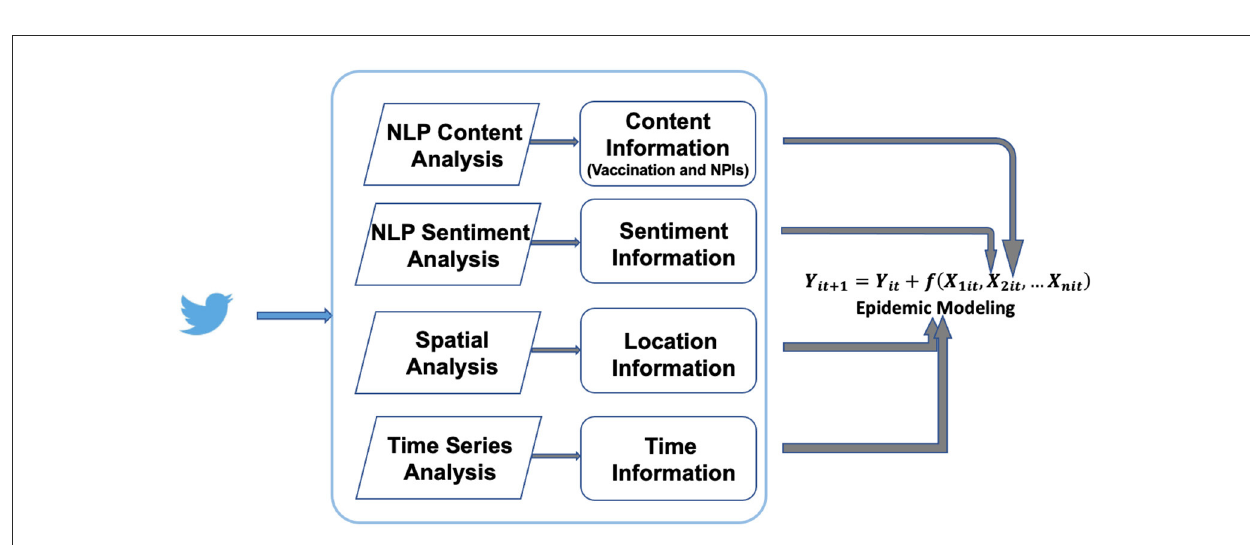
FIGURE2 Social media data mining, NLP, and integration with epidemic modeling.